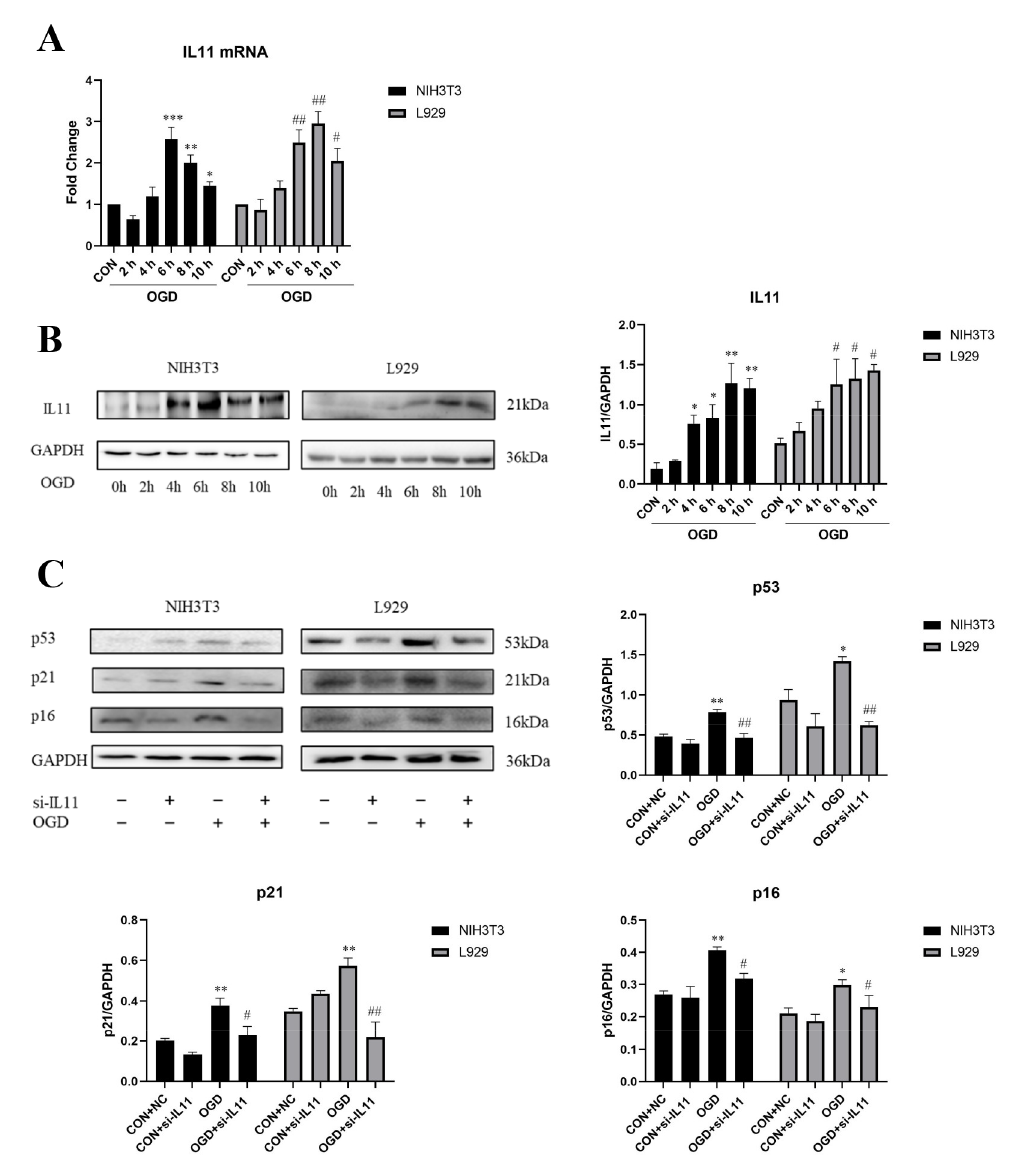
Figure 3. Interfering with IL11 inhibited fibroblast senescence. ( A ) mRNA expression estimated by RT-PCR for IL11 in NIH3T3 and L929 cells. ( B ) Western blot analysis and densitometric analysis of IL11 protein levels in NIH3T3 cells and L929 cells; GAPDH was used as the loading control. OGD—oxygen–glucose deprivation; CON—control. The results are presented as the means ± SDs, and Student’s t -test was used to determine the p -value. * p < 0.05, ** p < 0.01, and *** p < 0.001, compared with CON group in NIH3T3 cells; # p < 0.05 and ## p < 0.01, compared with CON group in L929 cells. ( C ) Western blot analysis and densitometric analysis of IL11, p53, p21, and p16 protein levels after inhibiting IL11 with siRNA in NIH3T3 and L929 cells.